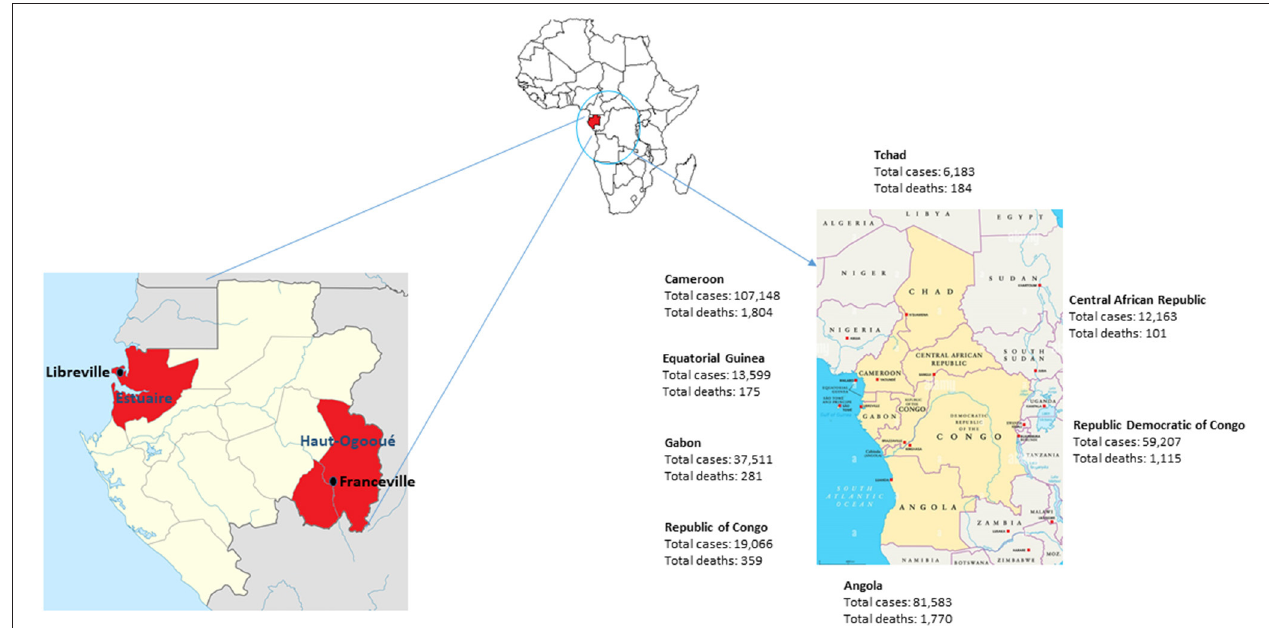
FIGURE 1 | Map of Gabon and its neighboring countries in Central Africa. Number of COVID-19 cases and deaths in December 2021.